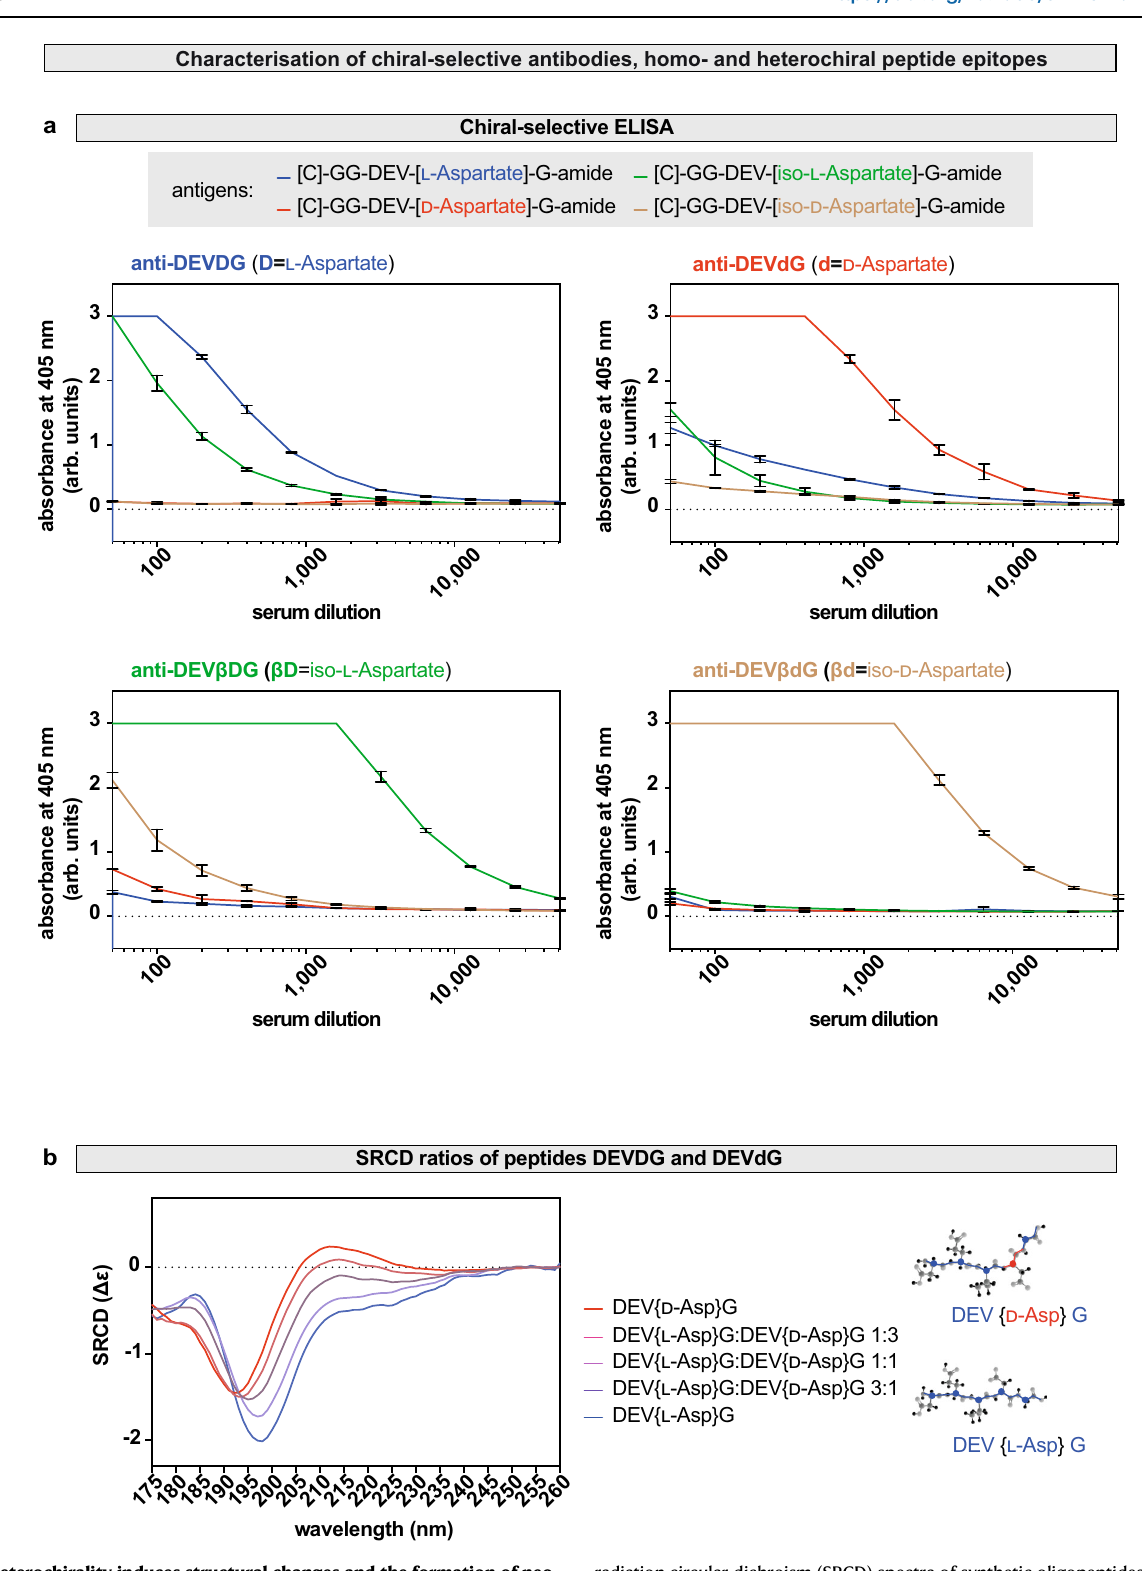
radiation circular dichroism (SRCD) spectra of synthetic oligopeptides: [C]-GG- DEV[ L -Asp]{P1}G-amide L -enantiopure control (blue), heterochiral [C]-GG-DEV[ D - Asp]{P1}G-amidepeptideinwhichtheP1aspartateisin D -form(red)andmixturesof homochiral and heterochiral oligopeptides in the indicated ratios. Stick repre- sentation of the homochiral DEVDG and its stereoisomer heterochiral DEV d G pentapeptide,wherethedin4 ′ positionrefersto D -Asp.Sourcedataareprovidedas a Source Data fi